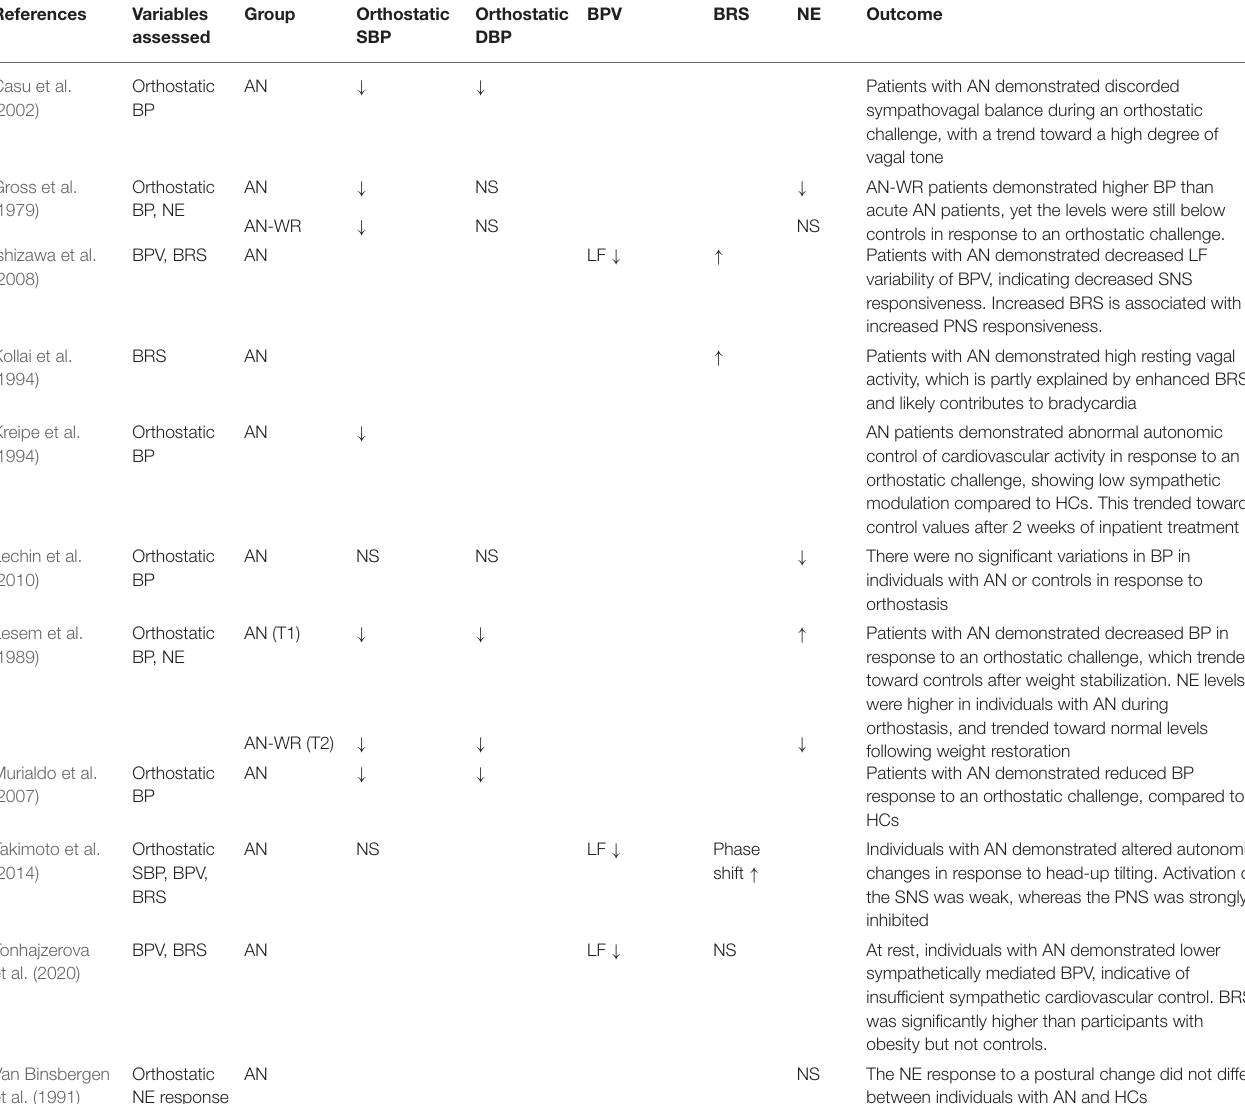
TABLE 4 | Orthostatic response, blood pressure variability and baroreflex sensitivity, as compared to